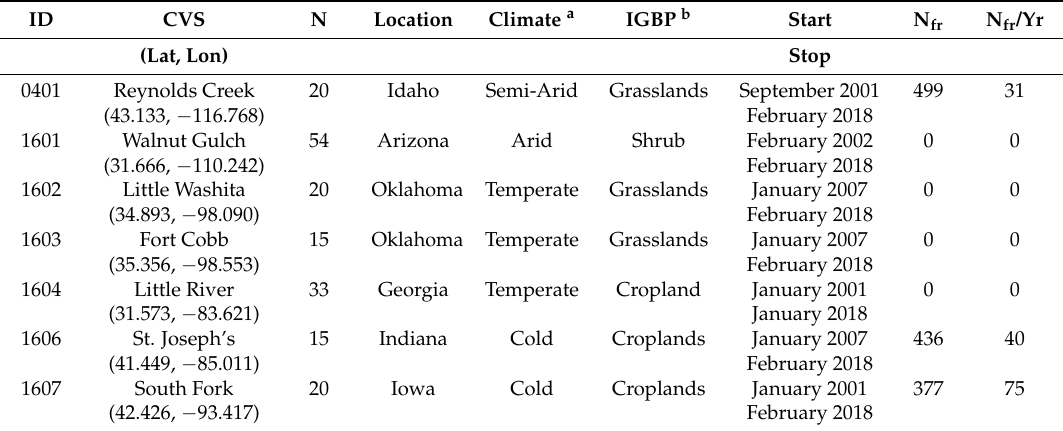
Table 1. SMAP core validation sites (CVS) along with counts of frozen soil occurrence at each CVS (N fr ), for period of record. The mean number of days that soils were frozen each year was computed by dividing N fr by the period (in years) and rounding to the nearest integer. N is the number of stations that are part of each CVS.